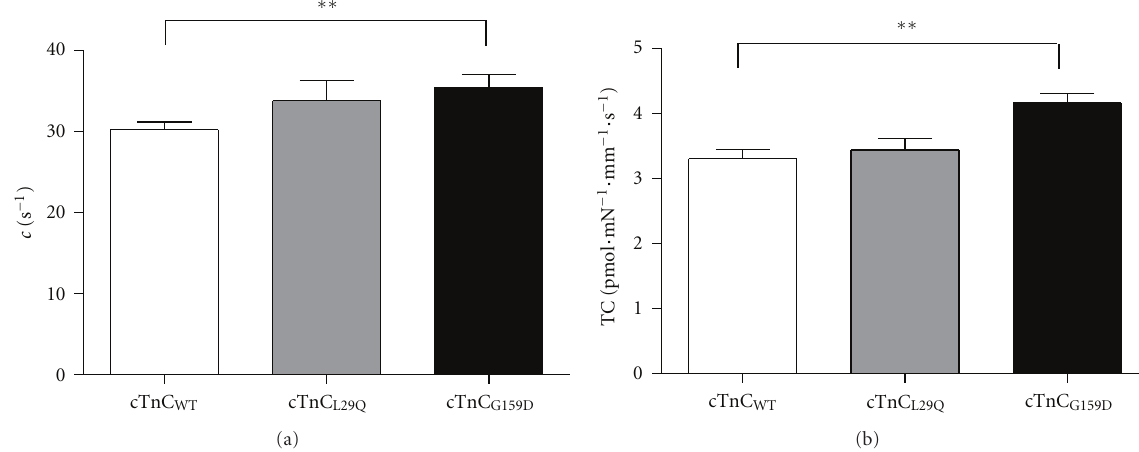
Figure 6: Comparison of XB distortion rate constant, c , and tension cost, TC, in detergent-skinned fibers reconstituted with cTnC WT , cTnC L29Q , or cTnC G159D . (a) E ff ects of RcTnC mutants on c. c was estimated by fitting the R-D model to the force responses from muscle fibers to chirp-length perturbations [35]. (b) E ff ects of RcTnC mutants on TC. TC was estimated by dividing the maximal ATPase activity with the maximal tension elicited by the muscle fiber. One-way ANOVA was used to compare estimates of c and TC in cTnC L29Q and cTnC G159D fibers with the data from cTnC WT fibers as controls. Values are reported as mean ± SEM. Number of fibers tested in each group is as follows: cTnC WT , n = 15; cTnC L29Q , n = 10; cTnC G159D , n = 14. Minimal statistical significance was set at α = 0 . 05, ∗∗ P < 0 .